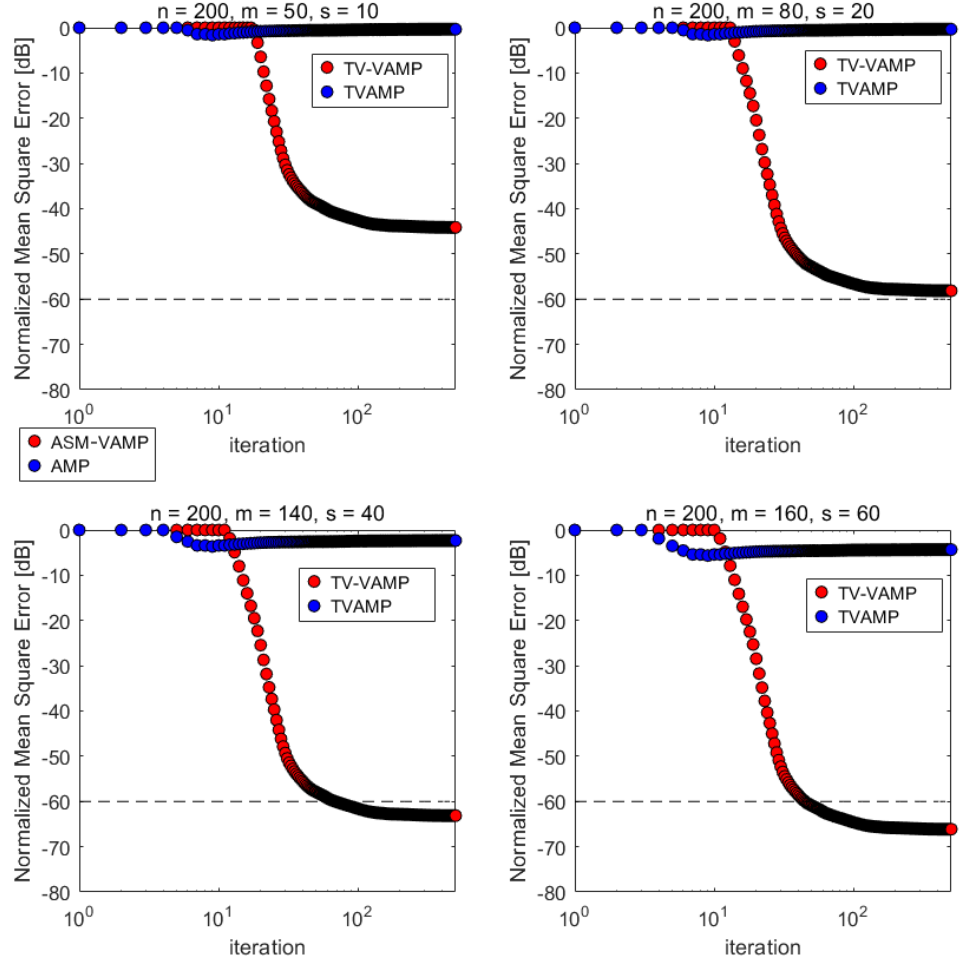
Figure 7. Normalized mean squared error (NMSE) convergence over iterations in the case of k ( A ) = 500 and n = 200. Each curve is the average of 50 Monte Carlo samples.